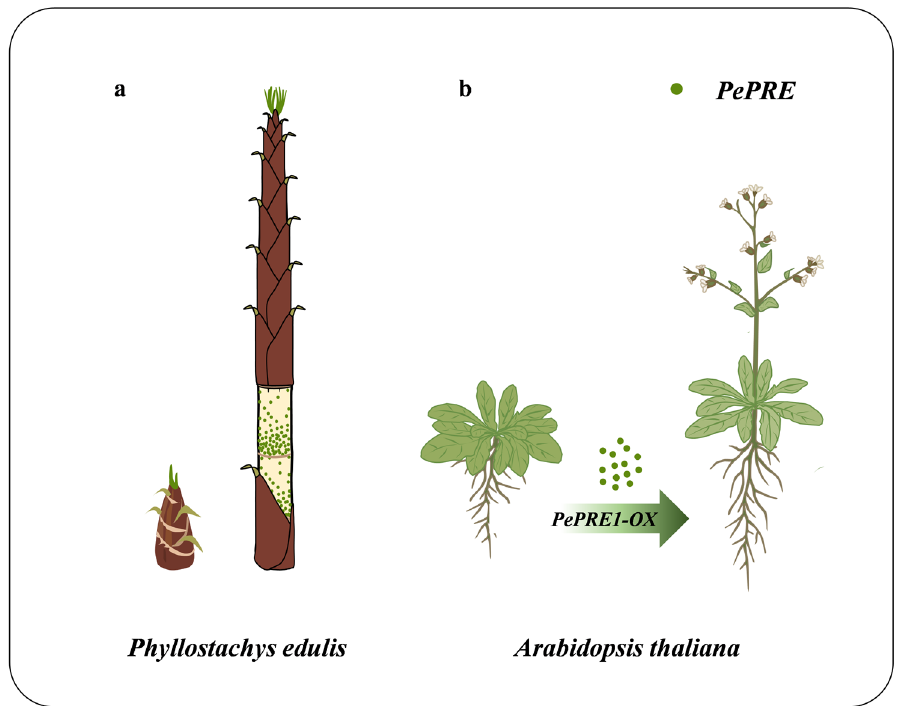
Figure 7. Diagram of PePRE1 gene expression and function. ( a ) Gradient expression levels of PePRE1 in the elongating internodes of moso bamboo shoots. ( b ) Overexpression of PePRE1 genes leads to early fl owering, longer hypocotyl, and growth promotion in Arabidopsis . Green dots indicate PePRE genes.